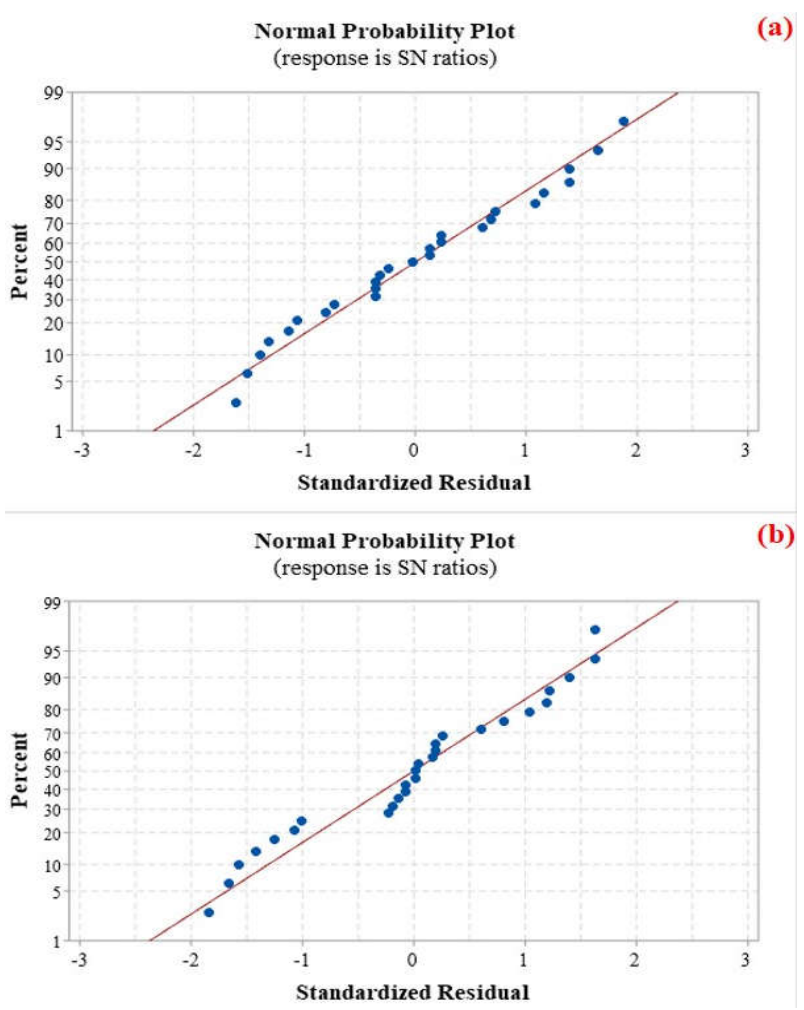
Figure 3. Normal probability plot of residuals when response is SN ratio ( a ) COF and ( b ) wear depth.